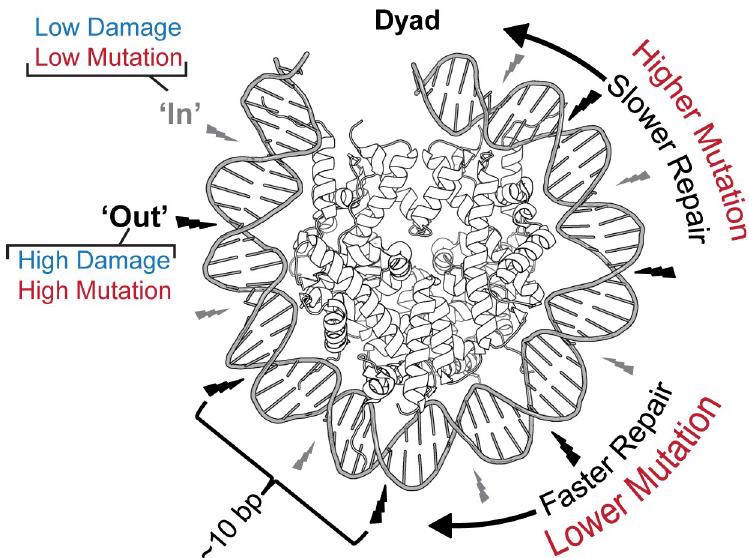
Fig 6. Mechanisms generating an extended UV-induced mutation signature within nucleosomes. Nucleosome structure increases CPD lesion formation at outward facing nucleosomes (black bolts) while decreasing NER activity near the dyad axis. Both processes combine to produce the 10bp oscillation of mutation across nucleosomes in melanoma as well as an overall curvature in mutation density across the translational setting of the nucleosome.